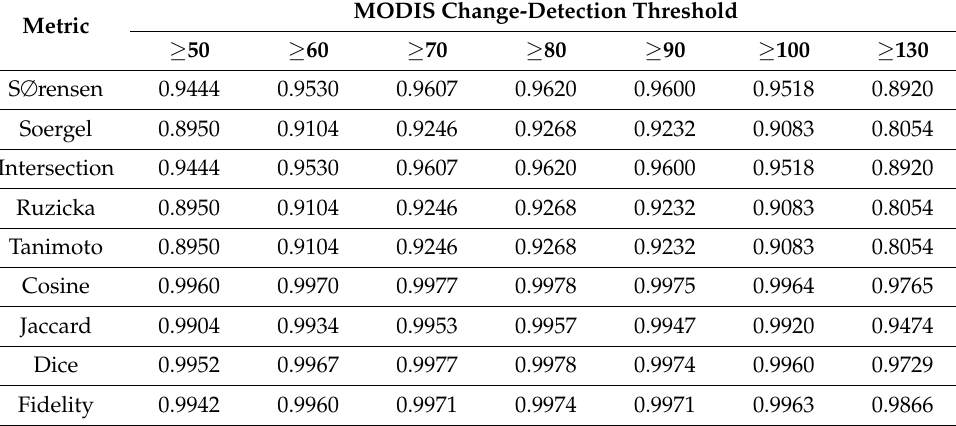
Table 3. Overall similarity (i.e., the average of θ and δ similarities) using nine metrics of spatial pattern between deforestation hotspots in Indonesia in 2020, derived from Landsat-8 OLI (at clarity ≥ 50% and deforestation intensity ≥ 50%) and deforestation hotspots in Indonesia in 2020 derived from MODIS (at change-detection thresholds ranging from 50 to 130).